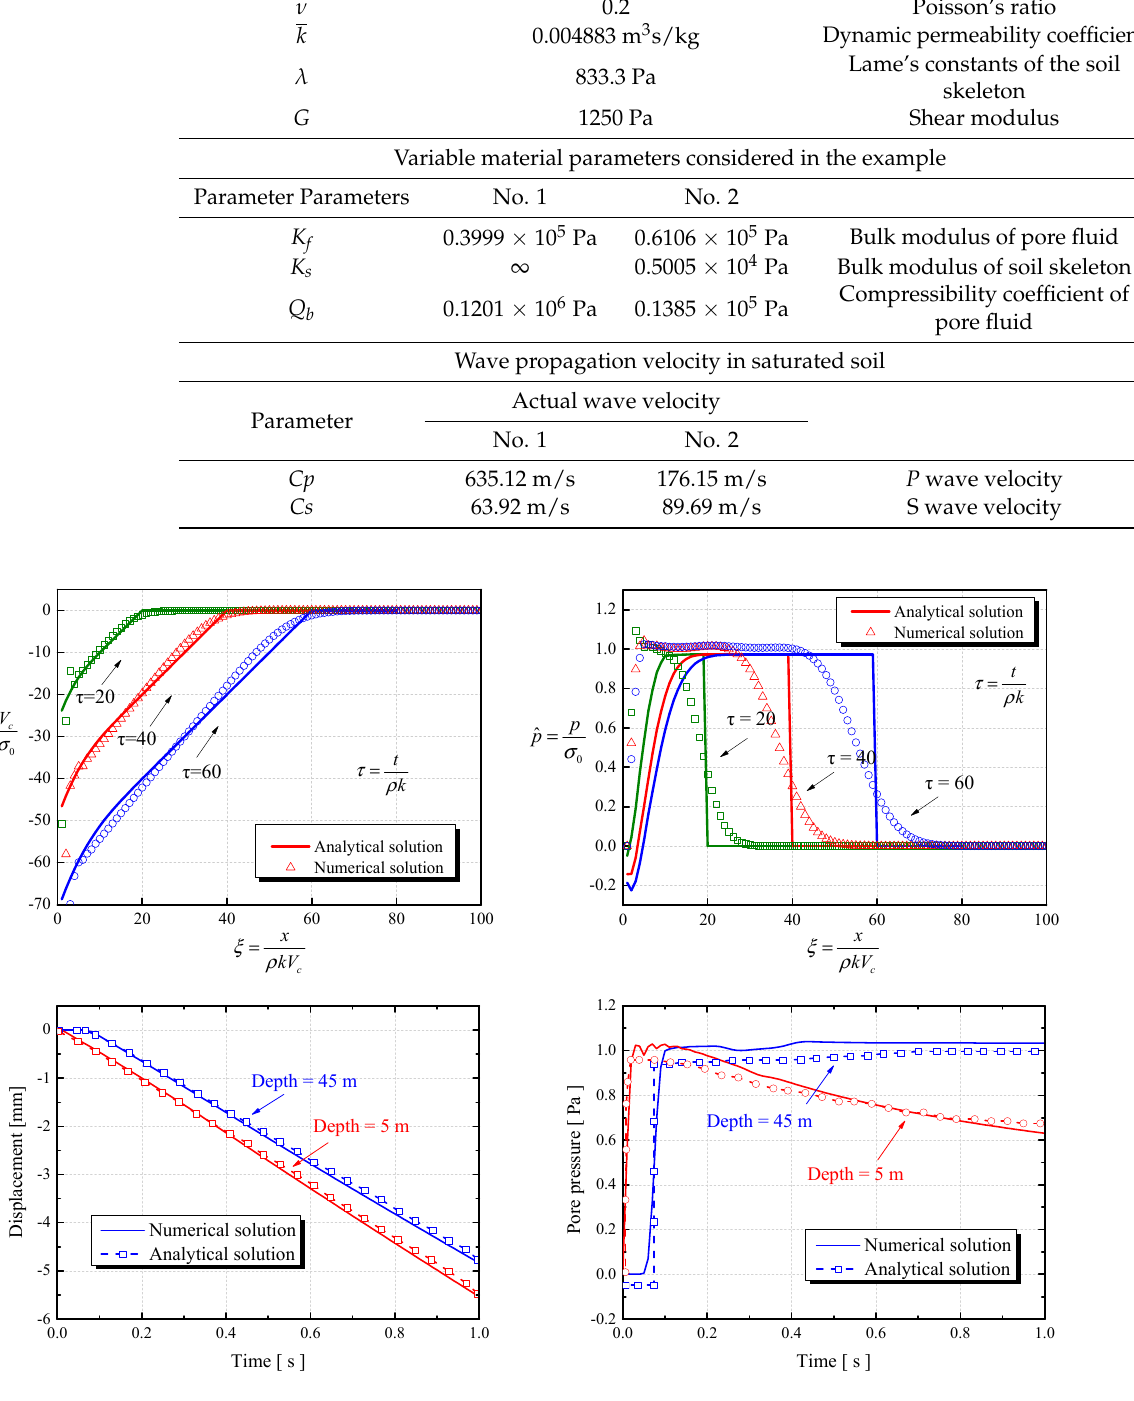
Figure 4. Comparison of numerical and analytical solutions for the 1D model of saturated porous media.